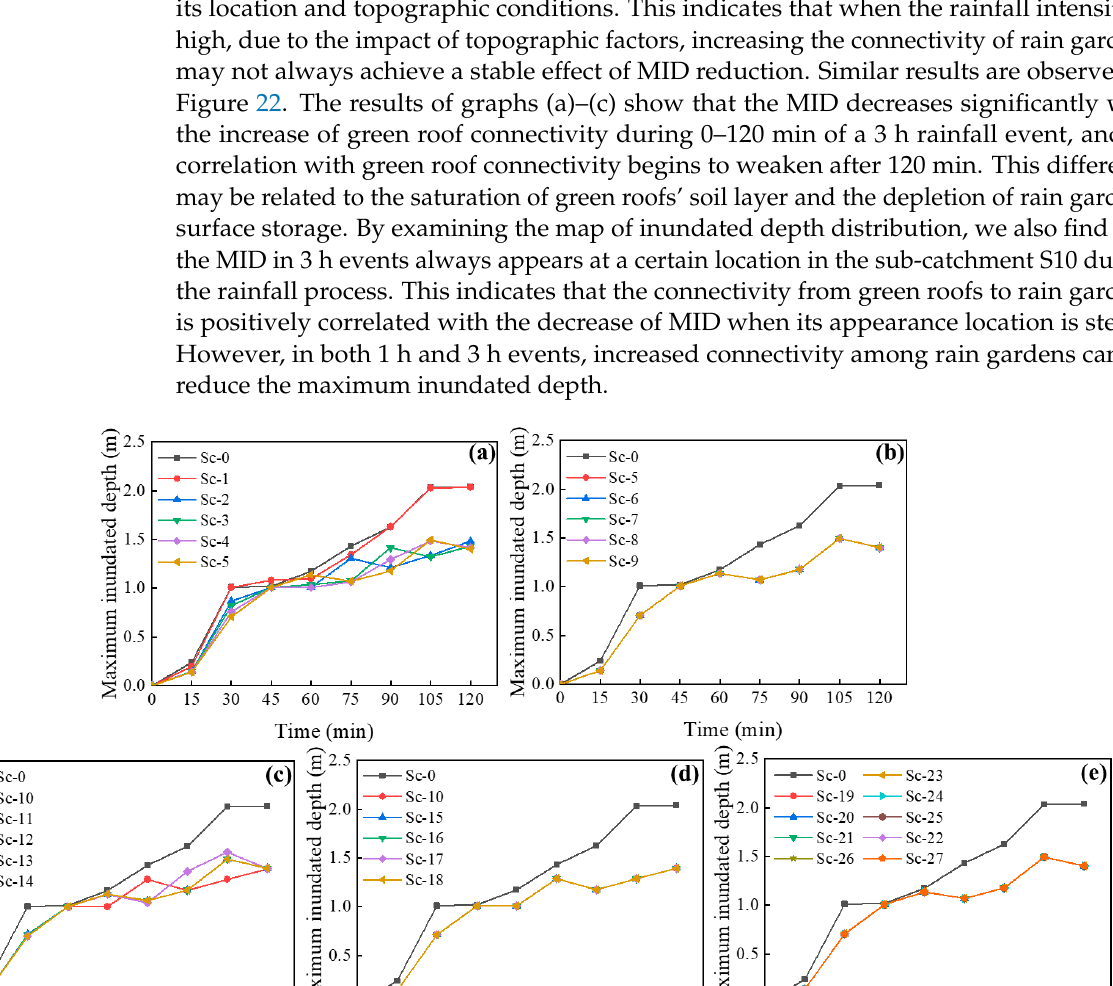
Figure 22. The time series plot of MID in 3 h event in considered scenarios of ( a ) connectedness of GR; ( b ) connectedness of RG; ( c ) edge density of GR; ( d ) edge density of RG; ( e ) flow distance of RG. 4. Discussion In terms of the impact of the spatial distribution of SuDS components on their flood reduction performance, there is currently a lack of a general guide and recommendations to support the spatial distribution design of SuDS components, especially at the commu- nity scale. According to the SuDS design process provided in the SuDS manual, the spatial distribution design of SuDS components should proceed in the outline design stage [25]. However, as for the specific design of the spatial distribution of SuDS components at the community scale, only nine urban typologies are provided in the SuDS manual as design examples [25]. These typologies cannot cover all the complex contexts in different com- munities, especially old ones. Based on the understanding of the primary flood reduction mechanisms of green roofs and rain gardens, we analyzed the effect of spatial distribution characteristics (con- nectivity, decentralization and position along flow direction) of green roofs and rain gar- dens at the community scale on flood reduction performance (TDV, ADFR, MDFR, and increasing trend of DFR, IA, AID and MID) of SuDS systems. Increased connectivity can